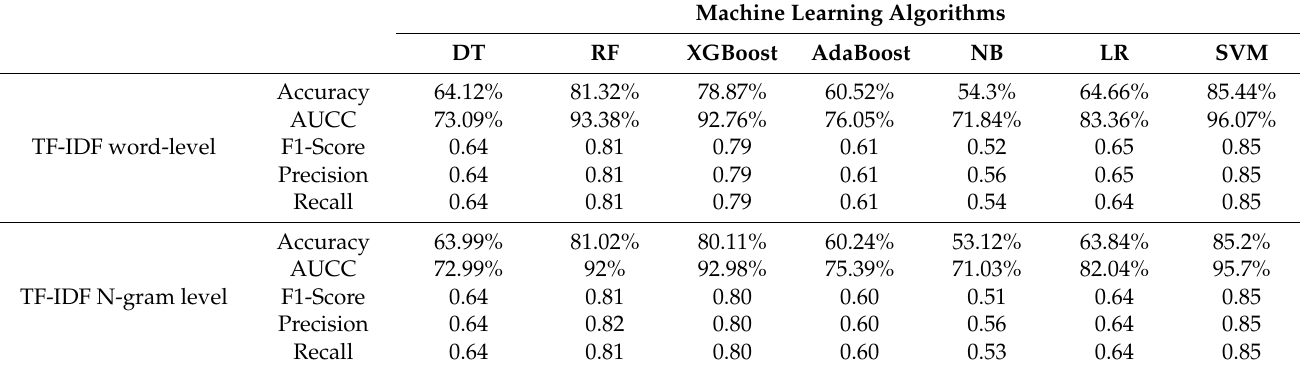
Table 1. Traditional classifier performance using